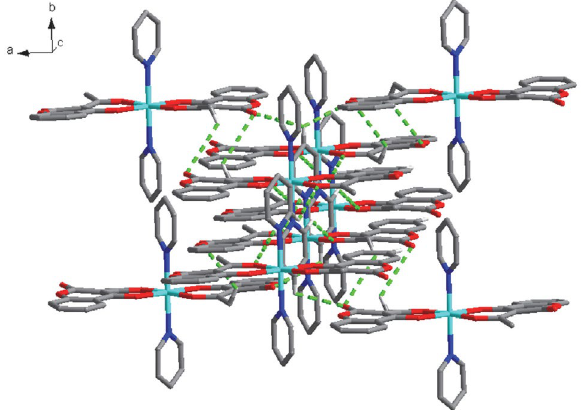
Figure 6. Crystal packing of complex showing the formation of a chain along [001], showing the intermolecular C–H ∙ ∙ ∙ O hydrogen bonds as thin green lines. Hydrogen atoms not involve in hydrogen bonding has been omitted for the sake of clarity .